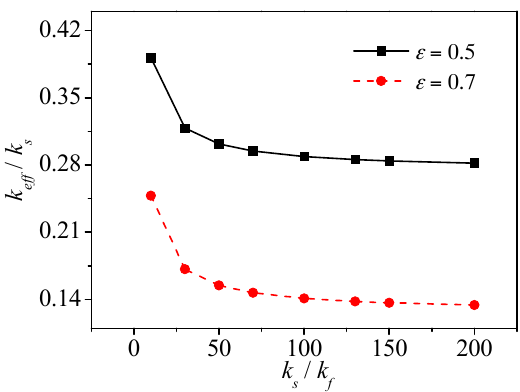
Figure 11. Effect of k s / k f on the effective thermal conductivity of the porous material.